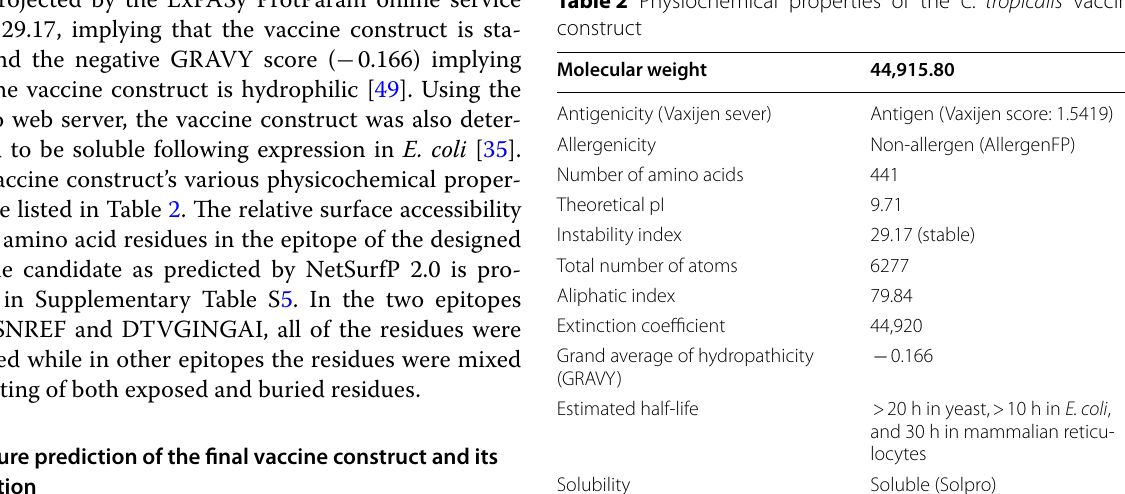
Table 2 Physiochemical properties of the C. tropicalis